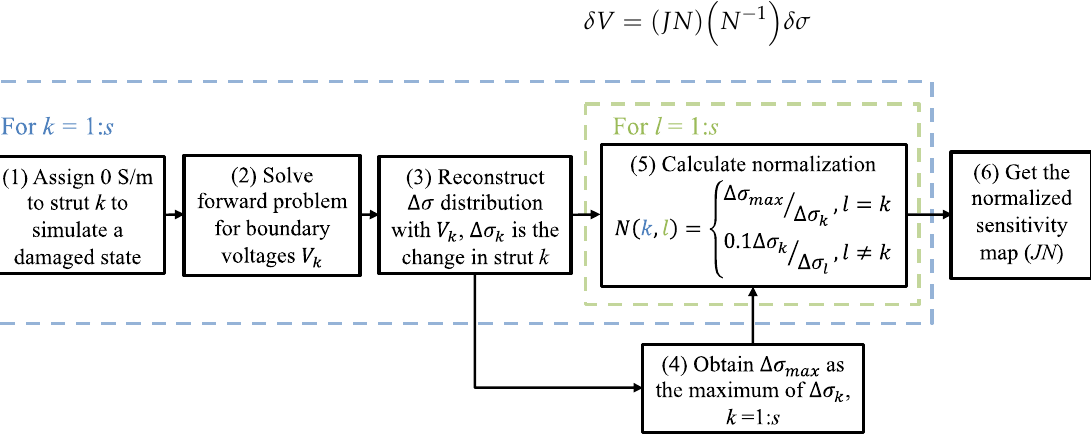
Figure 2. The flow chart illustrates the calculation of the normalized sensitivity map.